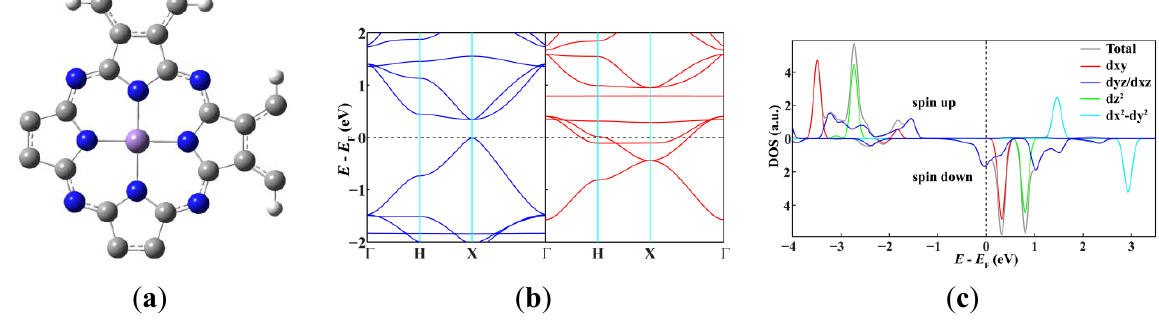
Figure 1. The optimized geometry structure of one unit cell ( a ) and the spin-resolved band structure ( b ) of the 2D MnPc sheet; ( c ) DOS projected onto the Mn 3d atomic orbitals.